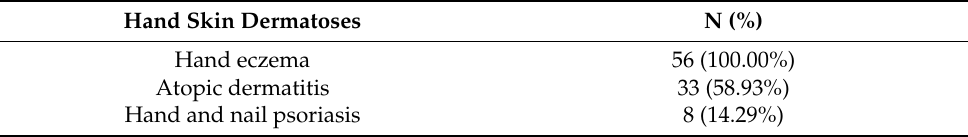
Table 2. Three most frequent hand skin dermatoses in HE-derm